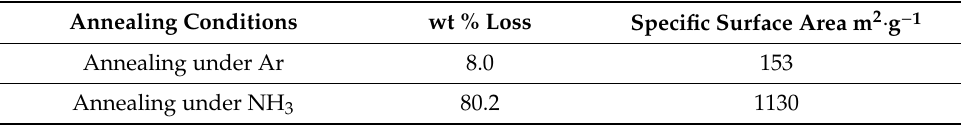
Table 2. Comparison of the weight loss and specific surface area of the annealed materials under argon and